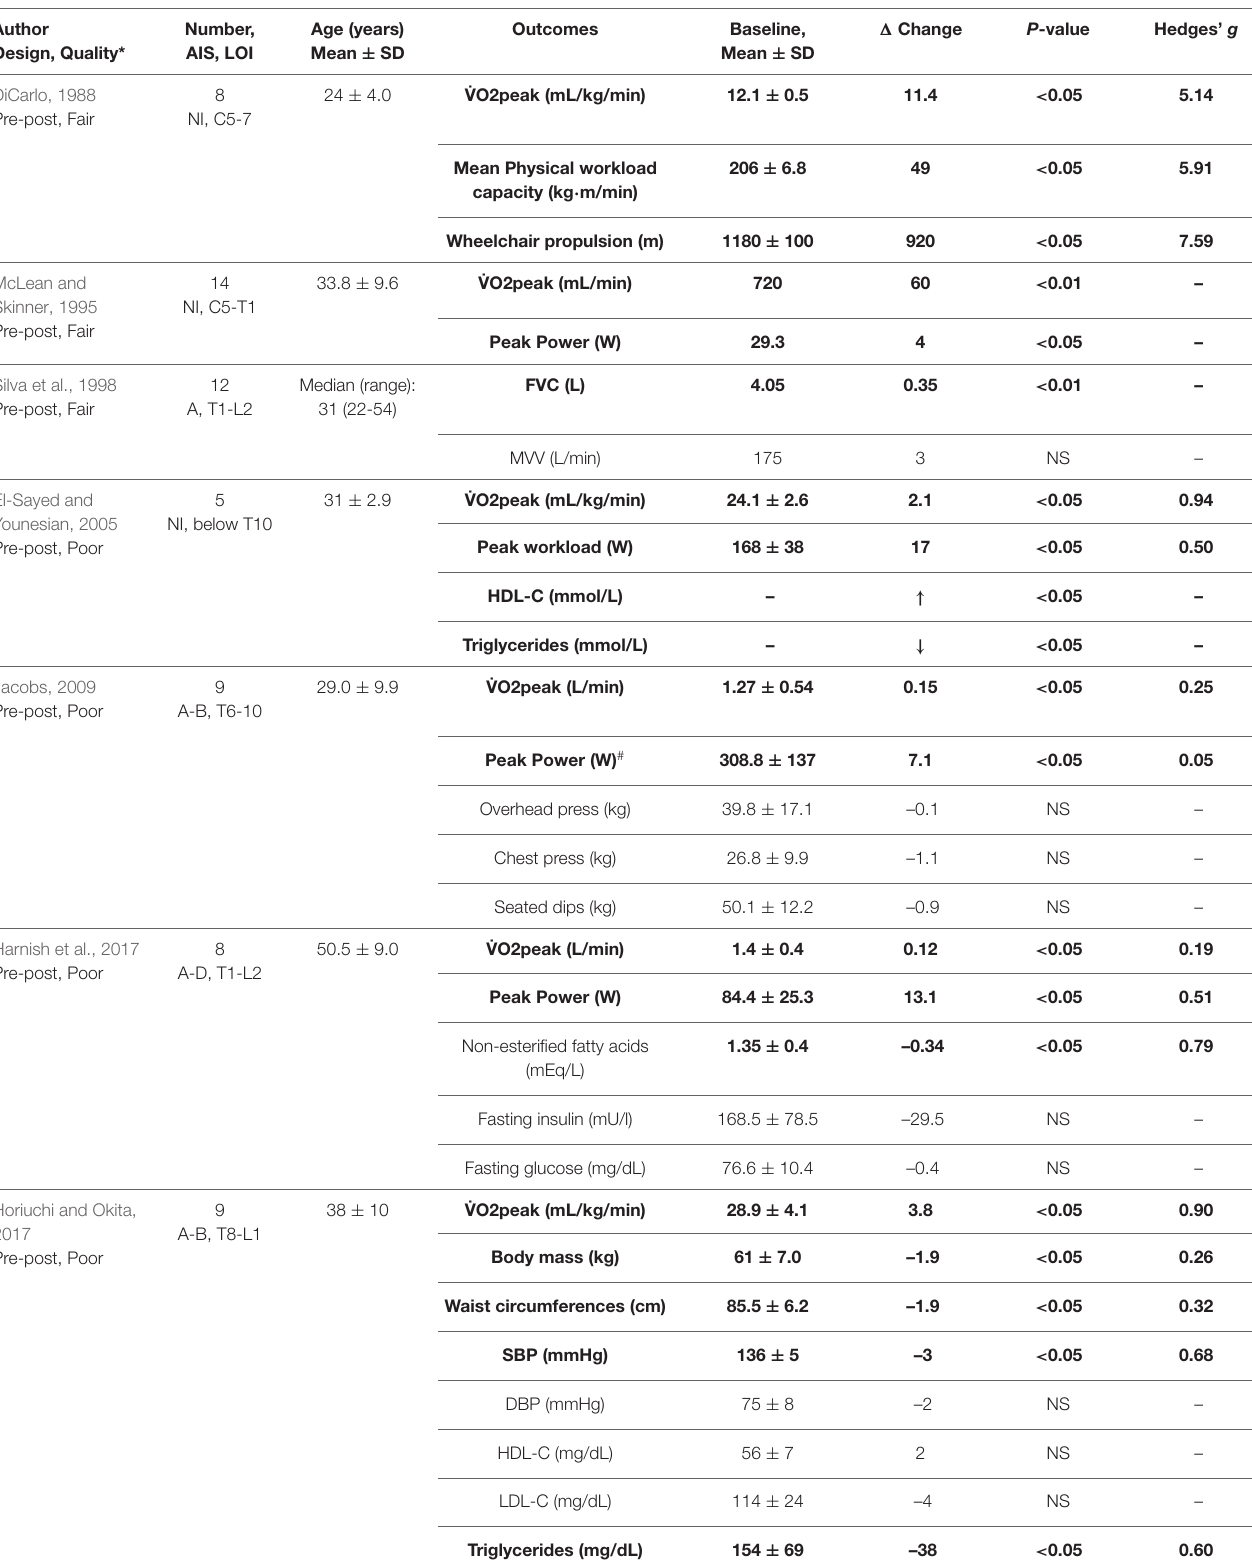
TABLE 2 | Detailed findings from specific pre–post design studies in the systematic